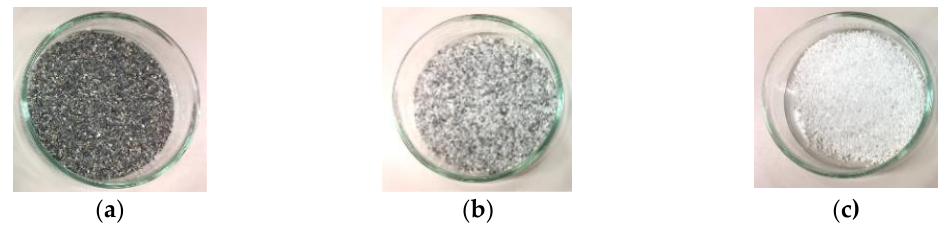
Figure 2. Samples of ( a ) Kawara limestone, ( b ) Ofunato limestone and ( c ) Garou limestone.